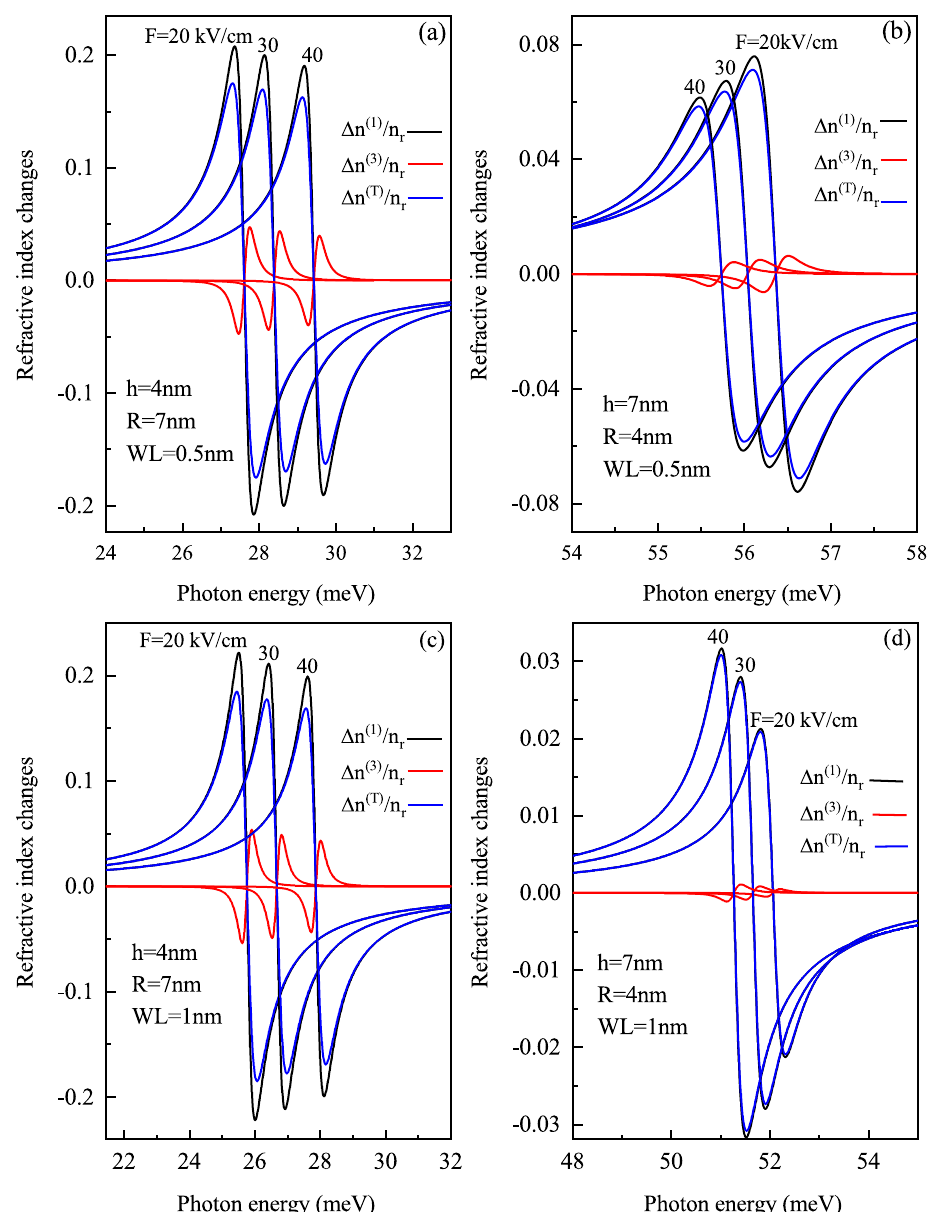
Figure 7. Linear, non-linear and total refractive index changes as a function of the photon energy for ( a ) oblate height R = 4 nm with radius R = 7 nm at WL thickness 0.5 nm ( b ) prolate QD with R = 4 nm, h = 7 nm with WL thickness = 0.5 nm, ( c ) oblate QD with R = 4 nm, R = 7 nm with WL thickness = 1 nm, and ( d ) prolate QD with R = 4 nm, h = 7 nm with WL thickness = 1 nm for different values of the lateral electric field F = 20,30 and 40